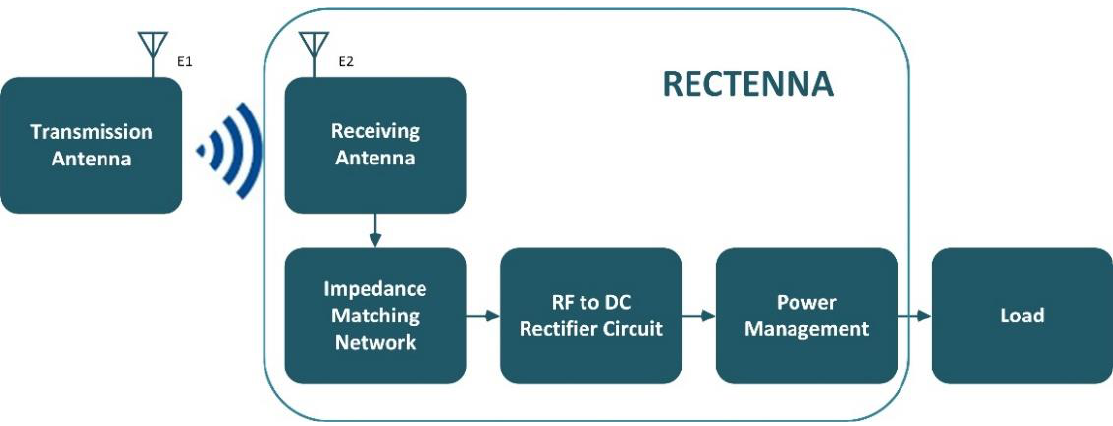
Figure 1. Block diagram of a typical RF harvesting system.